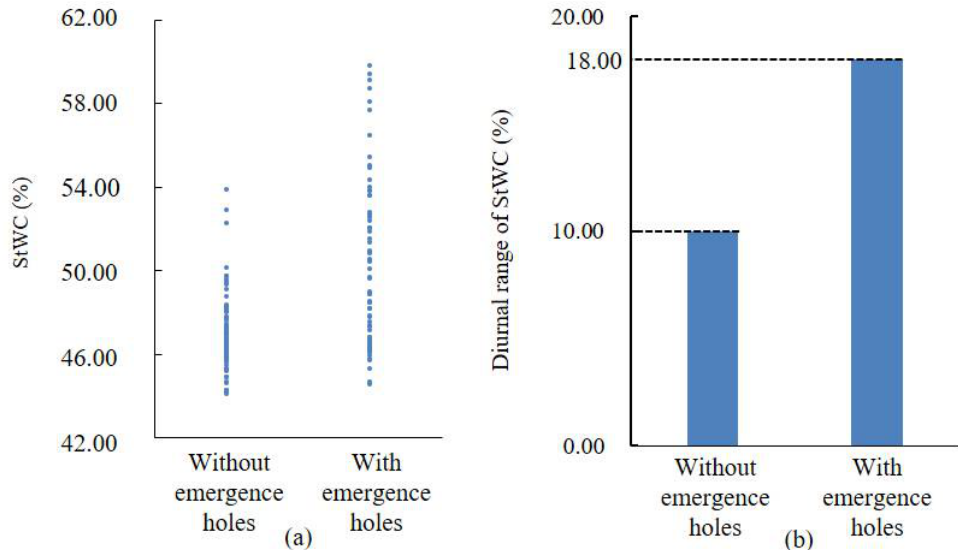
Figure 6. The first experimental group of Pinus sylvestris var. mongholica Litv. ( a ) StWC of trees without and with emergence holes. ( b ) Diurnal range of StWC.